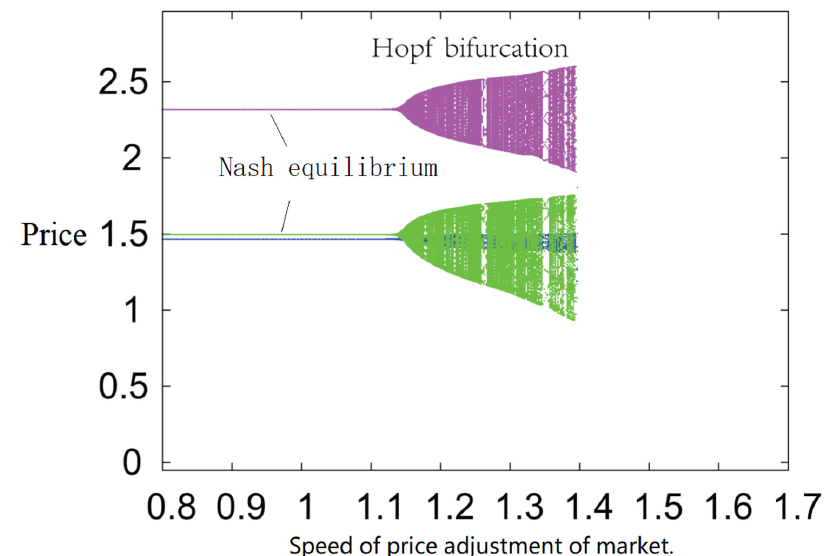
Figure 12. The Hopf bifurcation